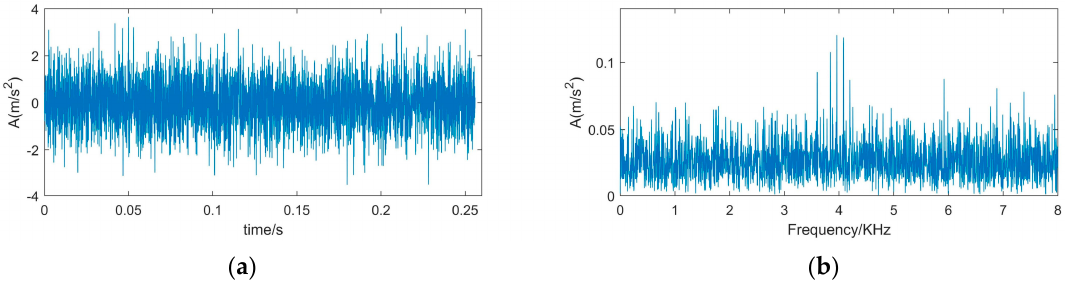
Figure 3. Time-domain waveform and frequency spectrum of simulated signal. ( a ) Waveform of simulated signal ( b ) spectrum of simulated signal.